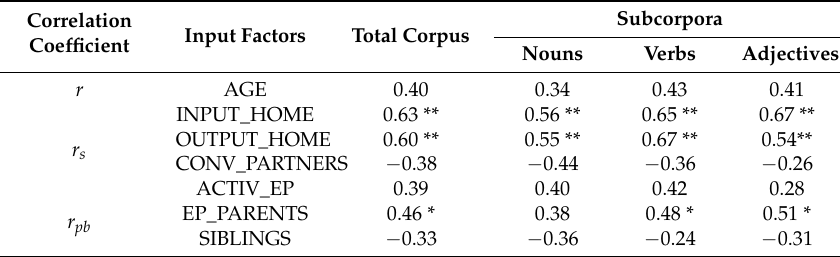
Table 2. Correlations between the input factors and the lexical performance of the